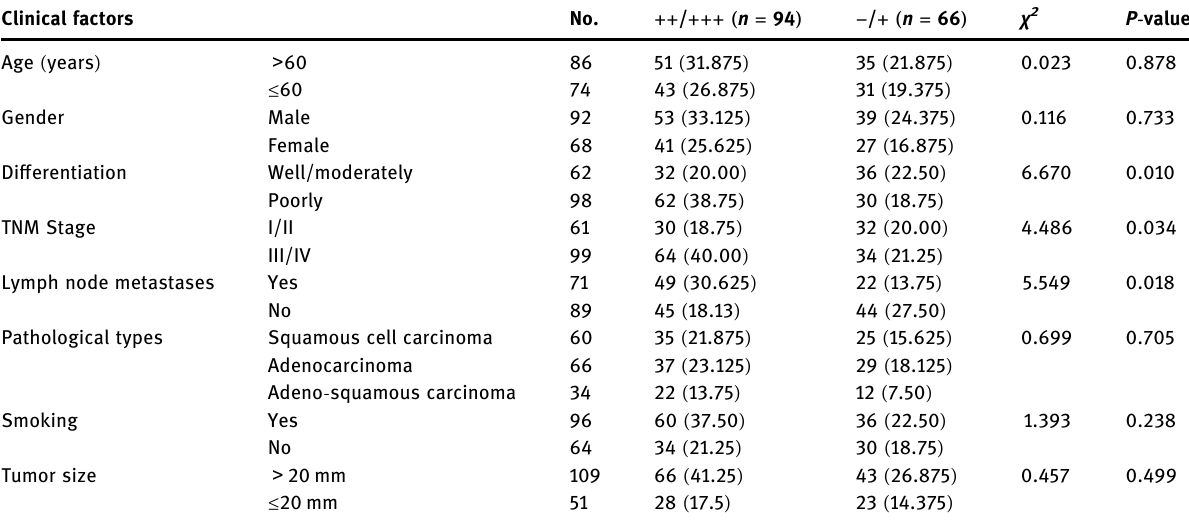
Table 1: The relationship between TS protein expression and clinicopathological factors Clinical